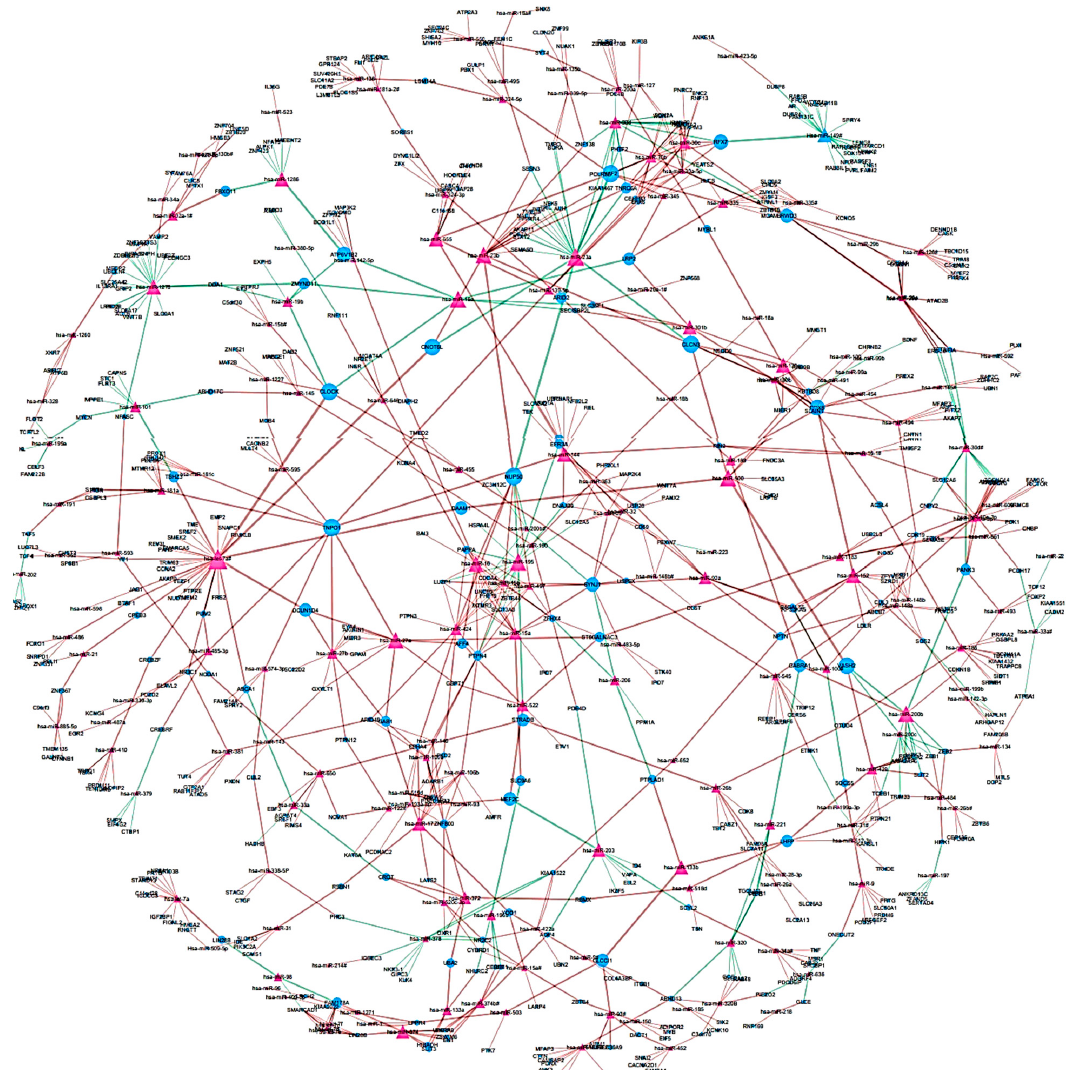
Figure 3. An Overview of the miRNA–target gene differential regulatory network (MGDRN); the purple triangular and blue circular nodes represent miRNAs and target genes, respectively. The size of nodes represents the degrees of nodes in the network. The brown and green edges in the MGDRN represent downregulation and upregulation involving liver disease versus normal conditions, respectively.